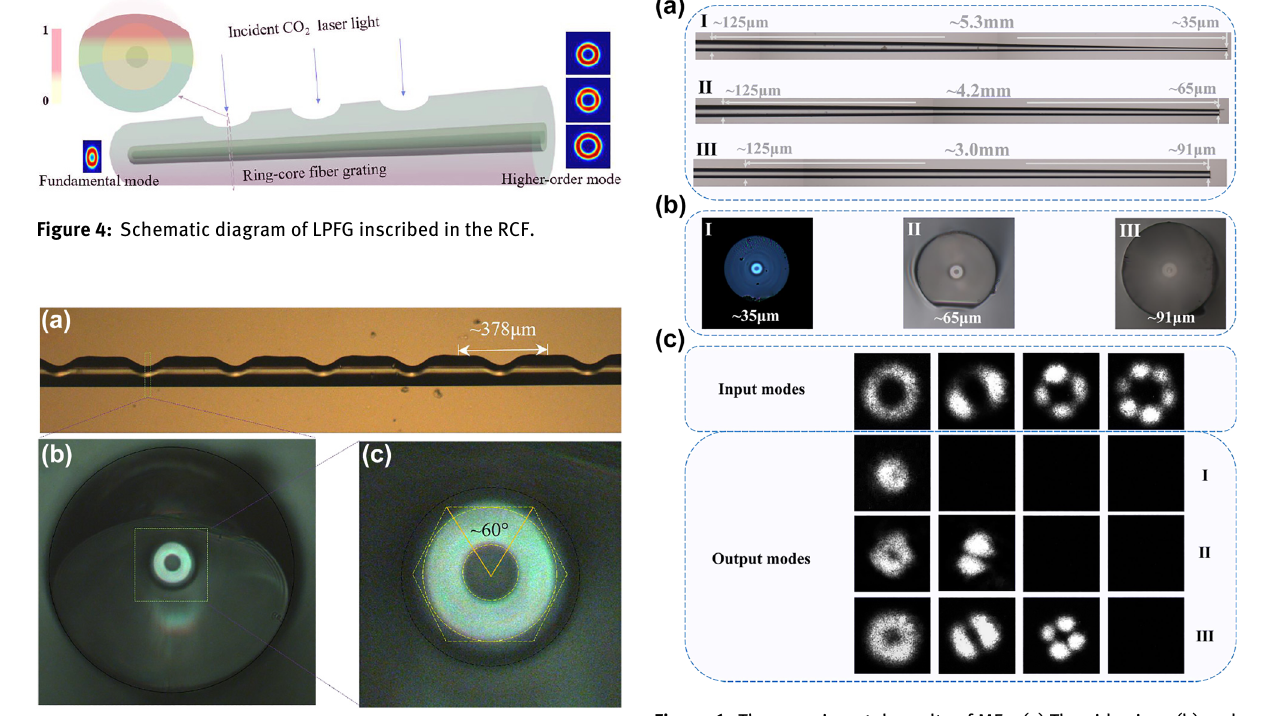
Figure 5: Images of the 3-order RCF grating. (a) Side view of the 3-order RCF grating; (b) and (c) end face of the 3-order RCF grating.